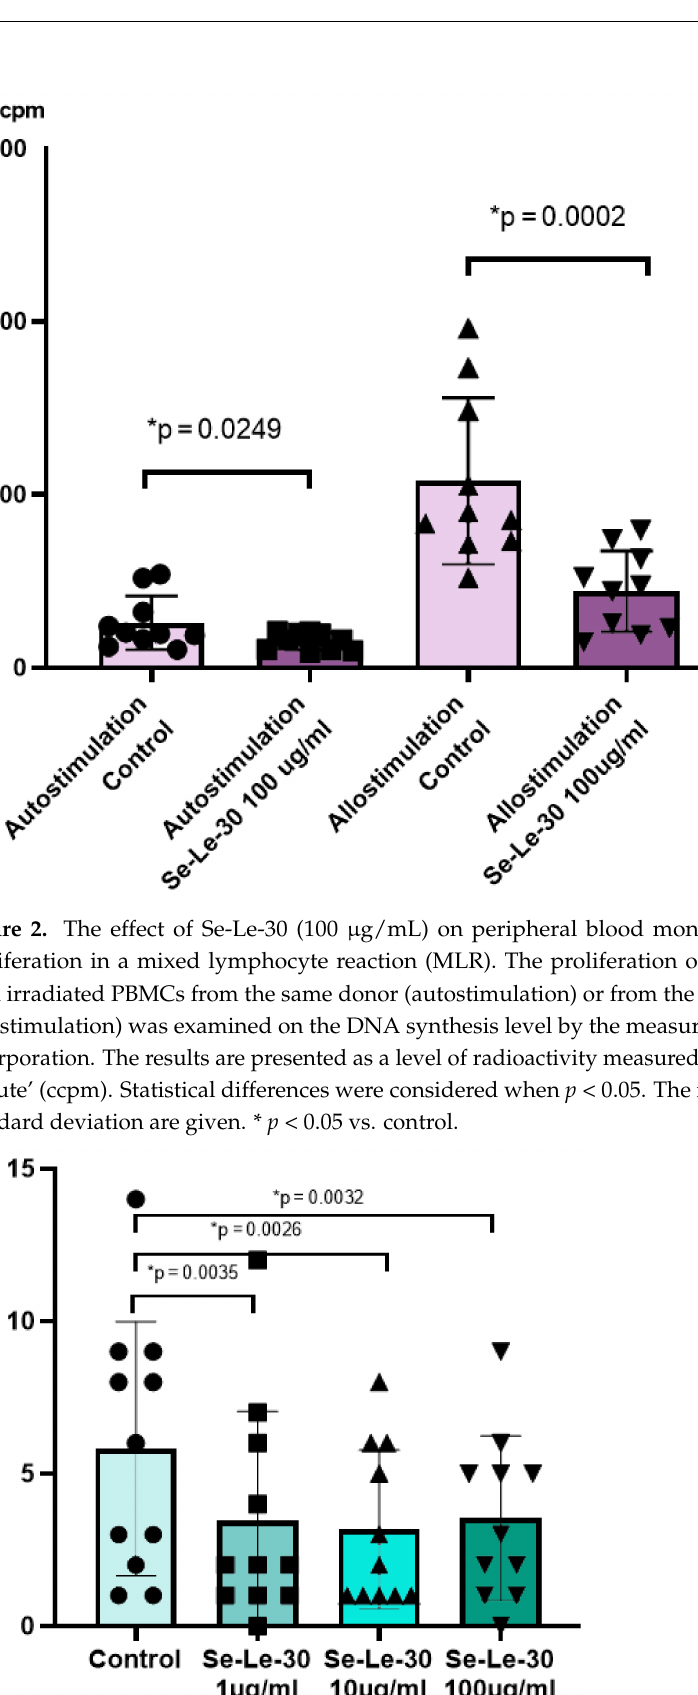
Figure 3. The effects of Se-Le-30 (in concentrations of 1, 10 and 100 µ g/mL) on the cytotoxic activity of human natural killer (NK) cells. Statistical differences were considered when p < 0.05. The mean value ( n = 11) and standard deviation are given. * p < 0.05 vs.